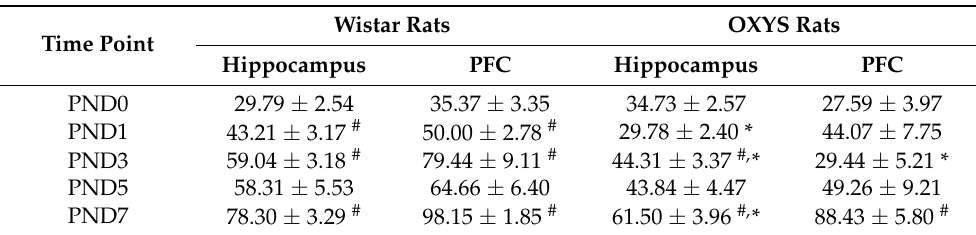
Table 5. The percentage of pyknotic nuclei phagocytosed by microglia in the hippocampus and PFC of OXYS and Wistar